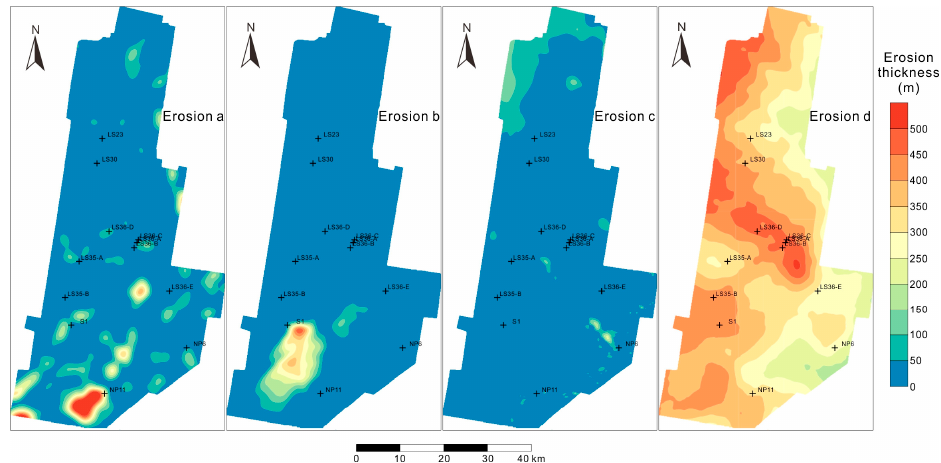
Figure 3 . The eroded thickness maps of the study area in the Lishui Sag. The erosion events are listed in Table 1.